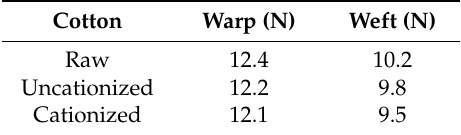
Table 1. Tear strength of raw, uncationized, and cationized cotton.